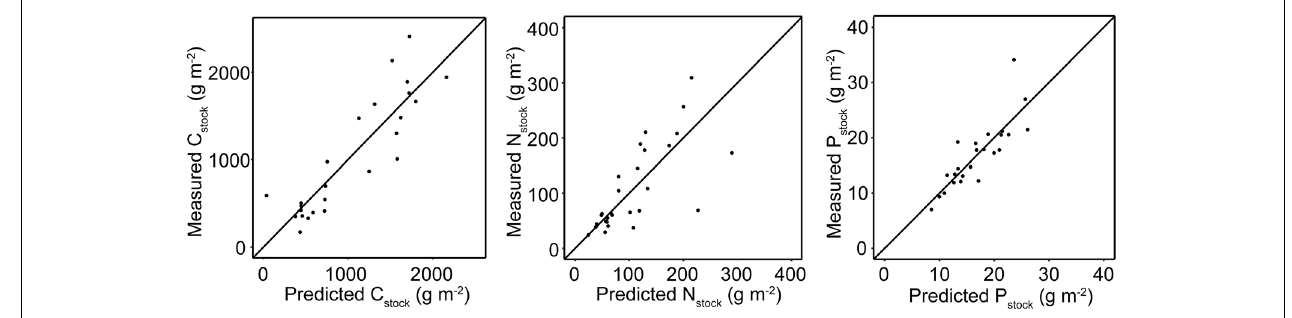
FIGURE 5 | Predicted vs. actual values of sediment stocks generated by the GLMs. The diagonal line has a slope of 1 and intercept of